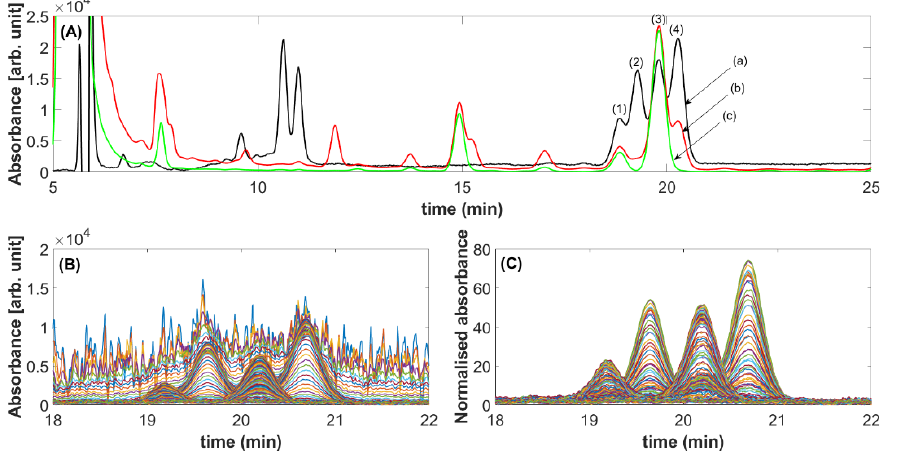
Figure 4. Deconvolution of the four components by itMPF with ( A ) D2nh, ( B ) D3nh and ( C ) D4nh.